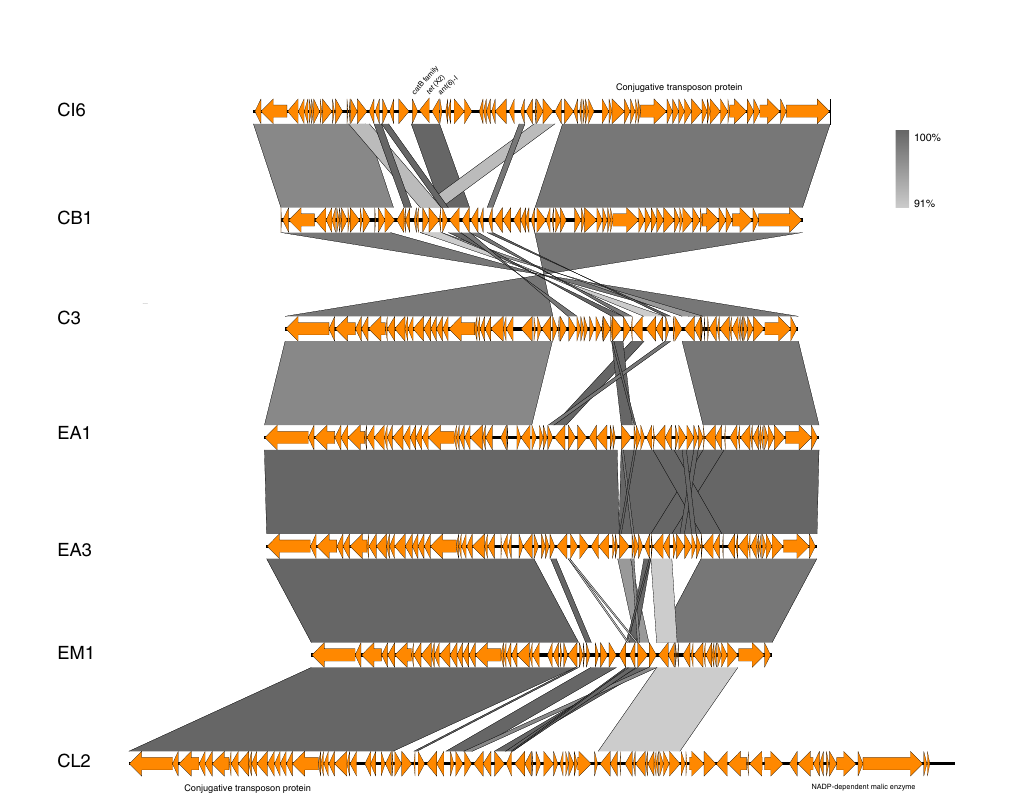
Fig. 4 Phylogeny of TetX generated by the maximum likelihood method. Blue and green backgrounds denote bacteria that belong to Proteobacteria and Bacteroidetes, respectively. Published (with accession numbers) and representative tet (X) orthologues are labeled with red font. The evolutionary history is depicted by using the Maximum Likelihood method and on the basis of the JTT matrix-based model. The tree with the highest log likelihood (-3778.5180) is shown. Initial tree(s) for the heuristic search were obtained automatically by applying Neighbor-Join and BioNJ algorithms to a matrix of pairwise distances estimated using a JTT model, and then selecting the topology with superior log likelihood value. The tree is drawn to scale, with branch lengths measured in the number of substitutions per site. The analysis involved 97 amino acid sequences. All positions containing gaps and missing data were eliminated. There is a total of 131 positions in the fi nal dataset. Evolutionary analyses were conducted with MEGA7 [2].